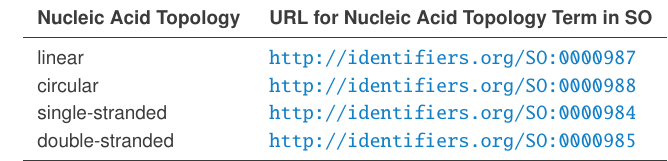
Table 3: Sequence Ontology (SO) terms to encode DNA or RNA topology information in the type properties of a Component .